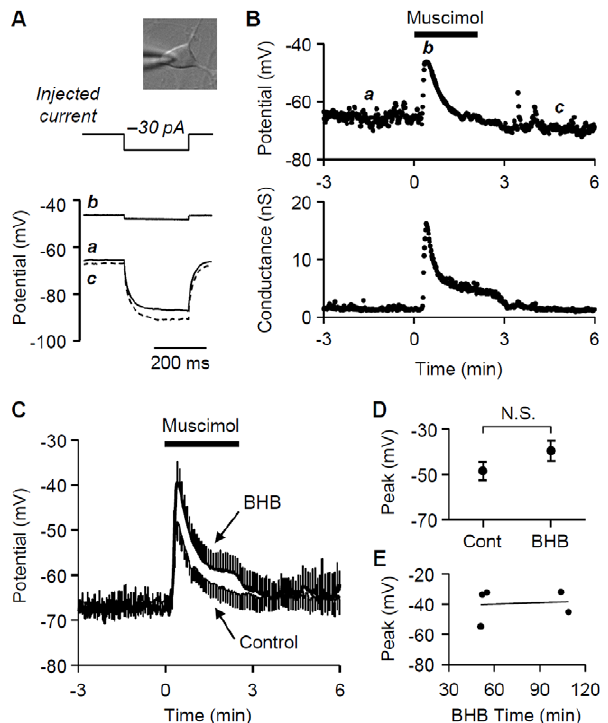
Figure 2. Muscimol-induced depolarization in BHB-treated hippocampal cultured neurons. A . In current clamp mode with gramicidin-perforated patch clamp, the membrane potential of a representative hippocampal neuron was recorded with repetitive injection of 2 30 pA step currents (250 ms duration) at 1 Hz. The voltage traces were sampled at the indicated time points of the graph in B. Inset, DIC image of a putative pyramidal neuron. B . Data from a representative control cell. The upper graph shows resting membrane potential measured at the baseline before the injection of 2 30 pA current. The lower graph is a plot of membrane conductance calculated from the maximum voltage deflection during the 2 30 pA injection. Muscimol (10 m M) was bath applied for 2 min. C . The averaged data show that muscimol (10 m M; 2–3 min) depolarized both BHB-treated (n=5) and control (n=5) cells. Error bars (S.E.M.) were plotted only every 5 s for clarity. D . The peak membrane potential during muscimol application was averaged over 5 s, and compared between control and BHB-treated neurons. N.S., not significant. E . From the BHB-treated cell, the peak membrane potential in muscimol was plotted against the duration of BHB treatment. The straight line is linear regression, y =0.03 x 2 42 (R 2